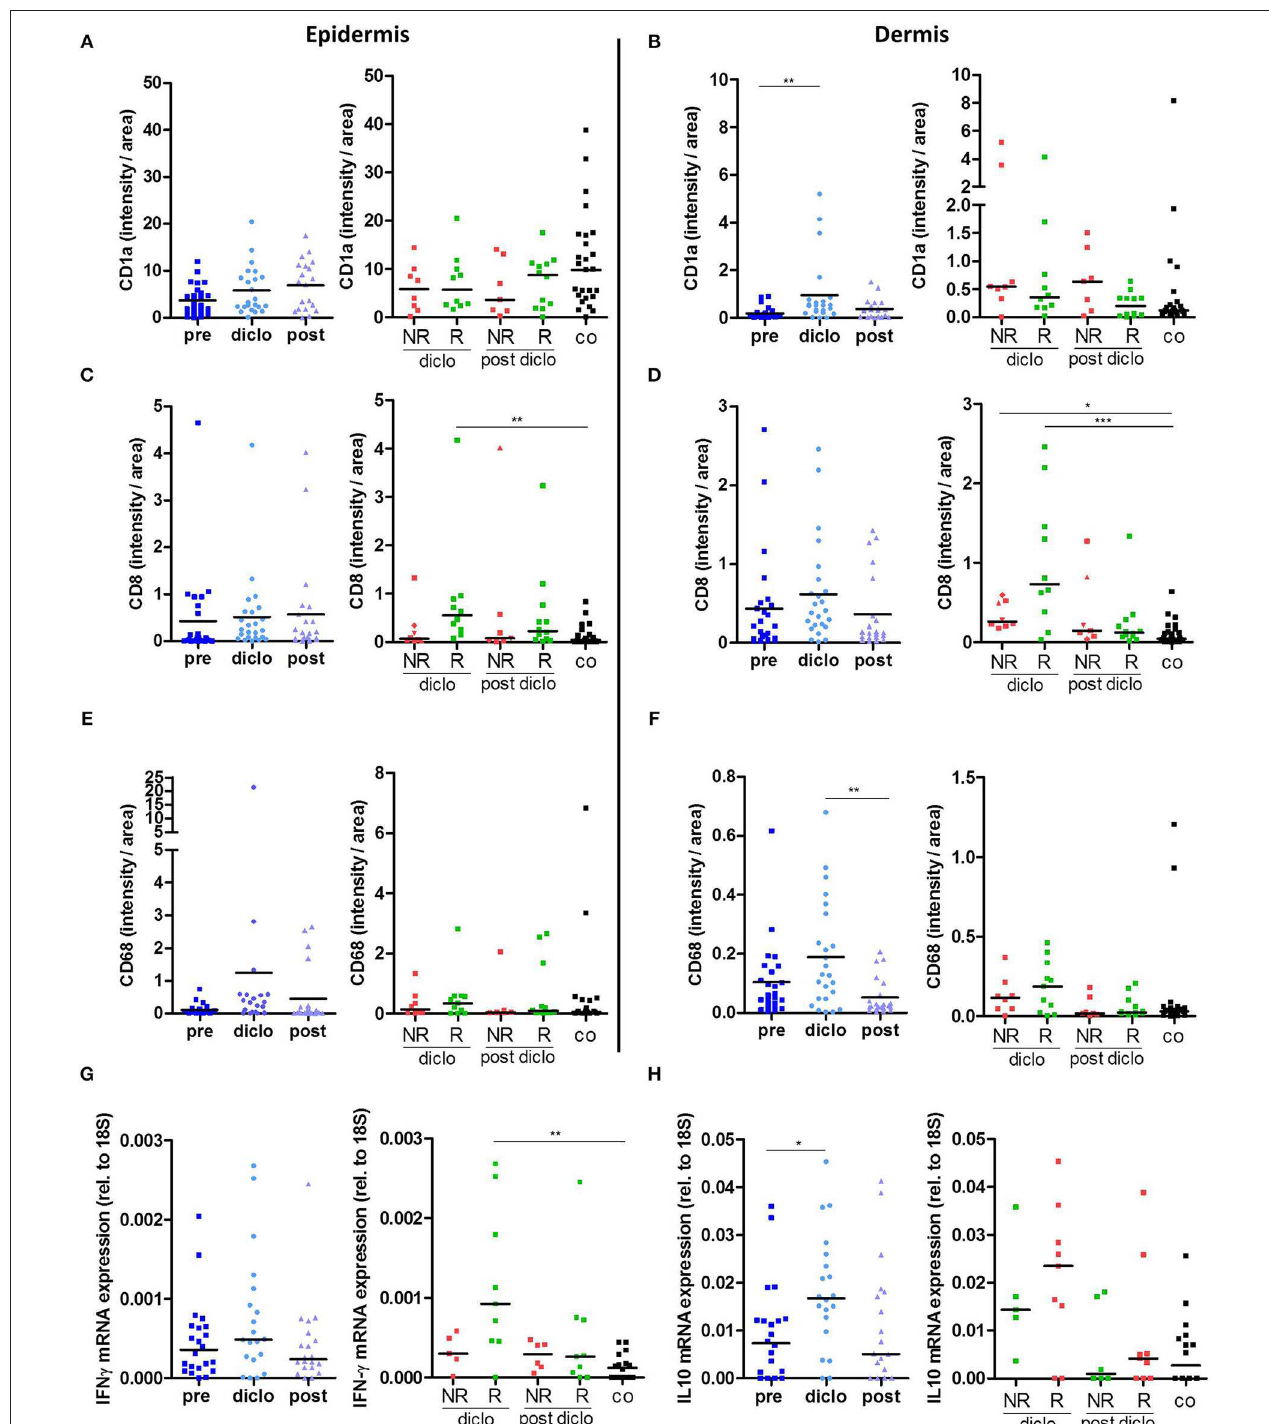
FIGURE 4 | Diclofenac induced an increased immune response. (A–E) Immunohistochemical staining of (A,B) CD1a, (C,D) CD8, and (E,F) CD68 in epidermis and dermis in actinic keratosis lesions (AK) and control skin biopsies (co). The selected pixels of the evaluated images were expressed as the percentage of the total area. (G,H) qRT-PCR analysis of (G) IFN- γ and (H) IL-10 gene expression in actinic keratosis lesions and control skin biopsies. Left graphs show all patients pre, on (diclo) and post treatment with diclofenac. Right graphs show non-responders (NR, n = 8) and responders (R, n = 12) to diclofenac on (diclo) and post treatment compared to controls (co). The dark lines indicate the median. * p < 0.05, ** p < 0.01, *** p < 0.001 (Kruskal-Wallis test).